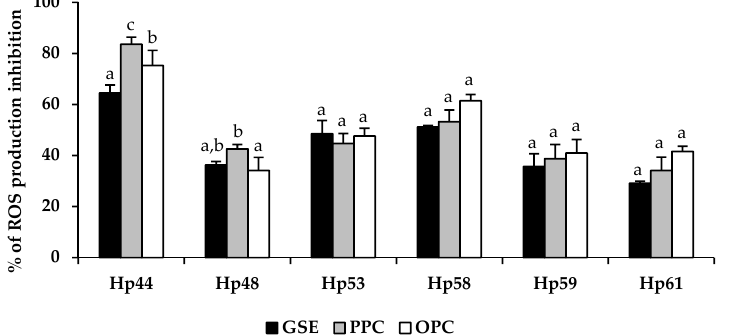
Figure 2. Protective effect of grape seed extract (GSE) and its polymeric procyanidin (PPC), and oligomeric procyanidin (OPC) fractions on intracellular reactive oxygen species (ROS) production. a, b, c values are expressed as inhibition of ROS production (%) (mean ± SD) with respect to the non- pre-treated control group ( n = 9). Bars with different letters indicate significant differences between GSE and its fractions in the inhibition of ROS production for each H. pylori strain, determined by ANOVA post hoc LSD Tukey test ( p ≤ 0.05).